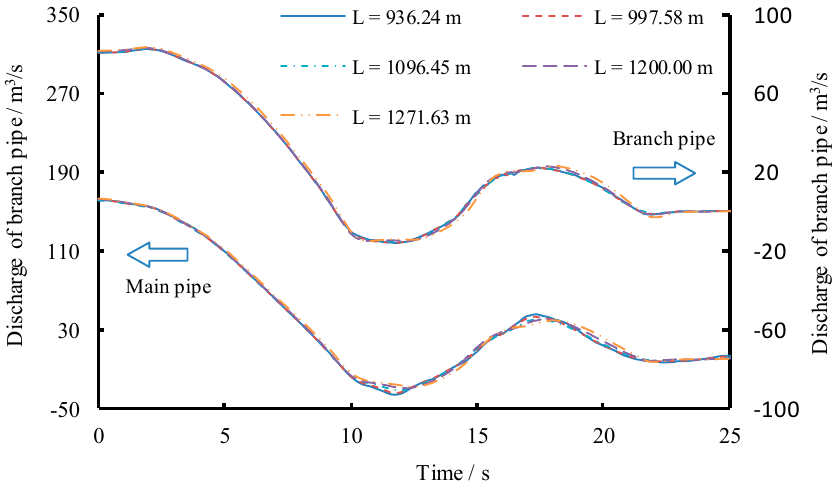
Figure 18. Maximum SCP with different time intervals for each scheme of Scenario 3.